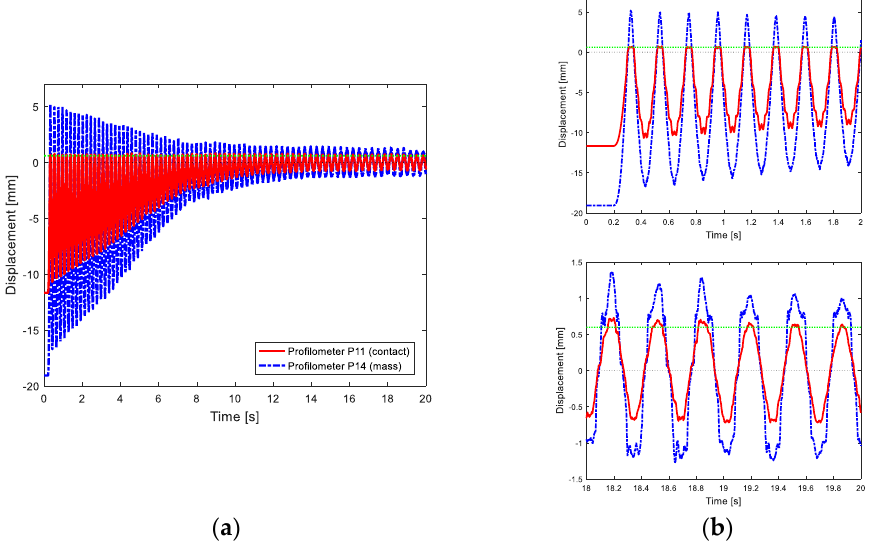
Figure 9. Time history of CD test using profilometer ( a ), with details at 0 – 2 s and 18 – 20 s ( b ); red line identifies the detected intermedial point, blue line the point detected at the mass..